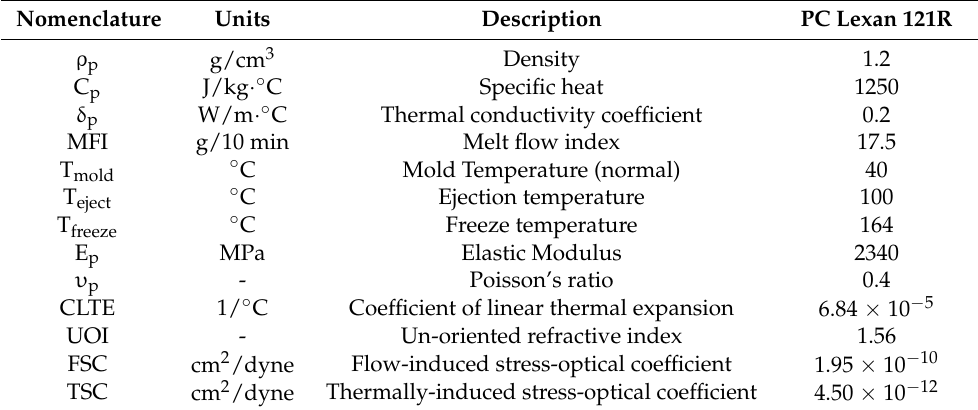
Table 2. Magnitude of the main properties of the material PC Lexan